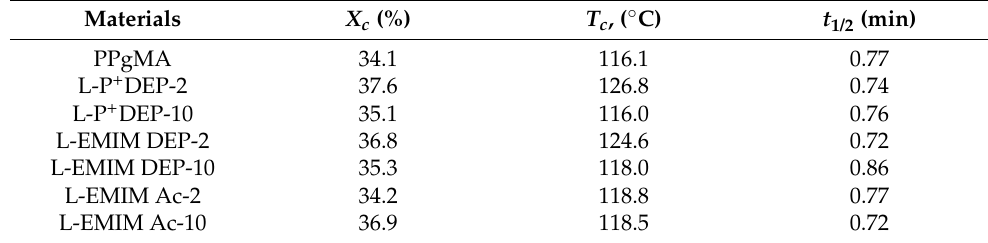
Table 3. The T c , t 1/2 , and X c values measured by DSC (heating and cooling rates: 5 K · min − 1